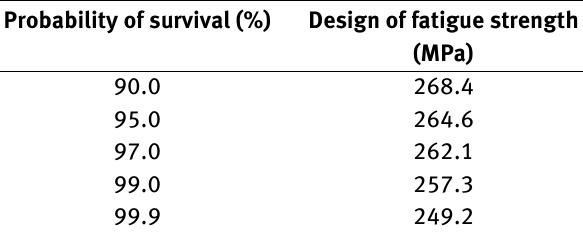
Table 4: Design of fatigue strength for some reliability values based on current results.